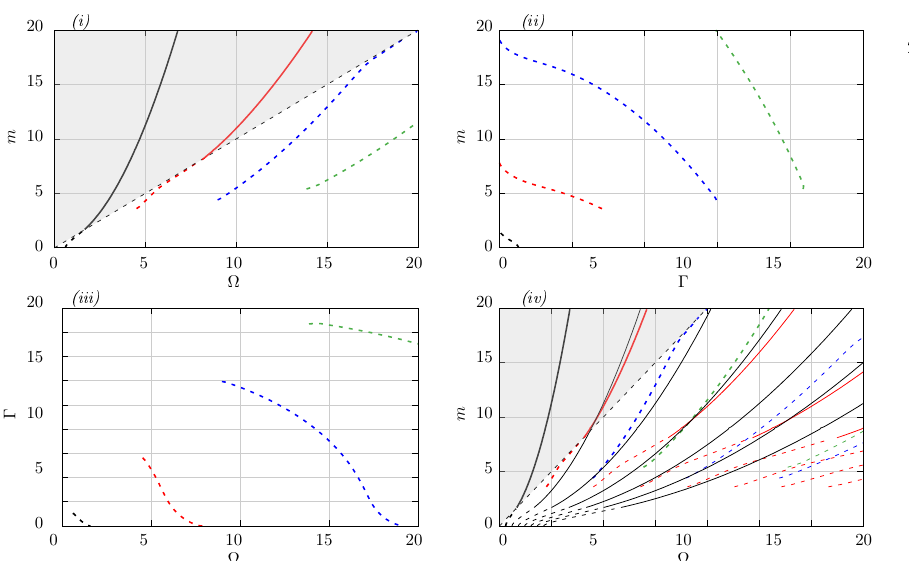
Figure 2 . Resonance modes for the usual Skyrme potential with the pion mass m part of the frequencies of the oscillational/resonance modes, (ii) imaginary part (damping) of the resonance modes, (iii) resonance positions in the complex plane ((cid:10) ; (cid:0)), (iv) resonances/oscillational modes and their higher harmonics.